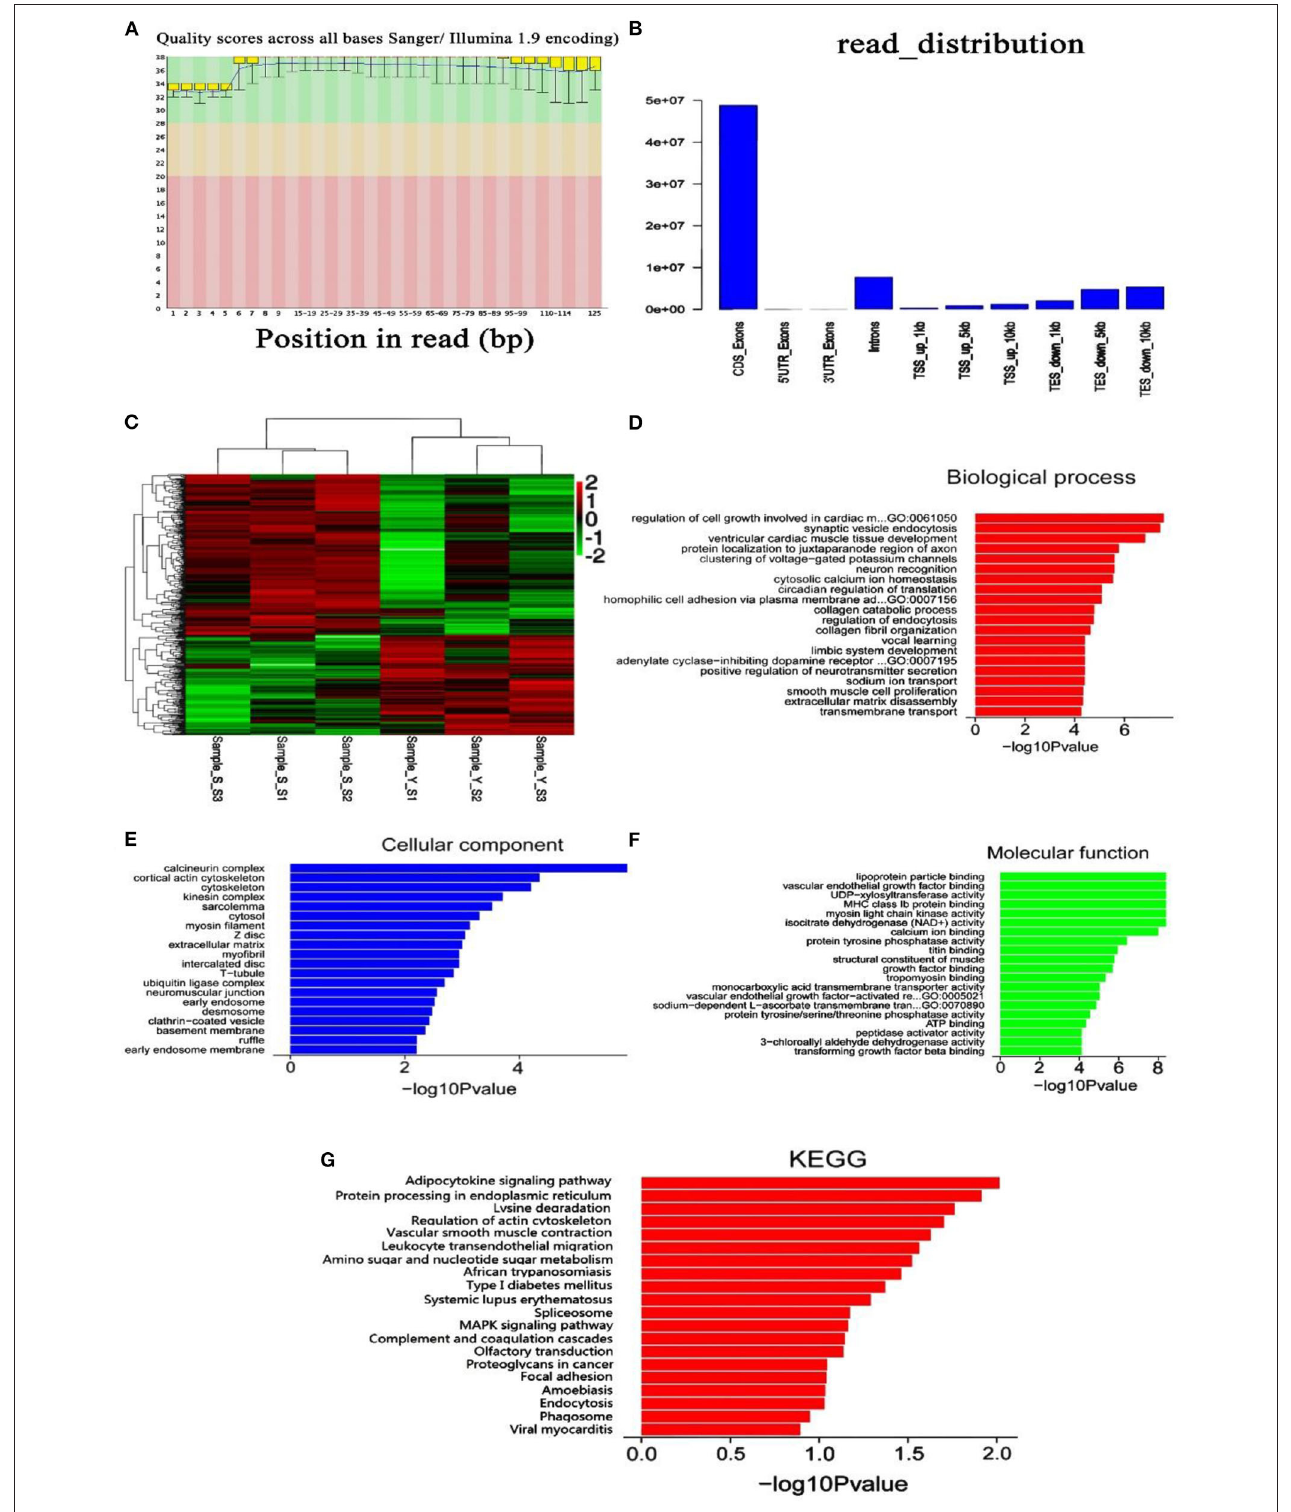
FIGURE 4 | Transcriptome sequencing analysis. (A) Quality distribution of the original database group; (B) distribution of the original samples in different patterns; (C) cluster analysis of differentially expressed genes; (D) annotation of biological process; (E) annotation of cellular components; (F) annotation of molecular function; (G) annotation of KEGG